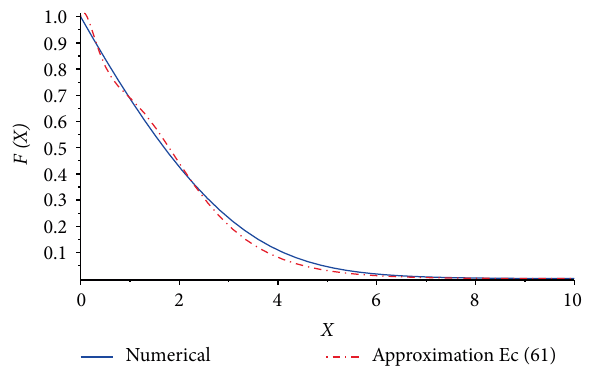
Figure 7: Comparison between numerical solution of (33) and approximate solution (61) for 휀 =